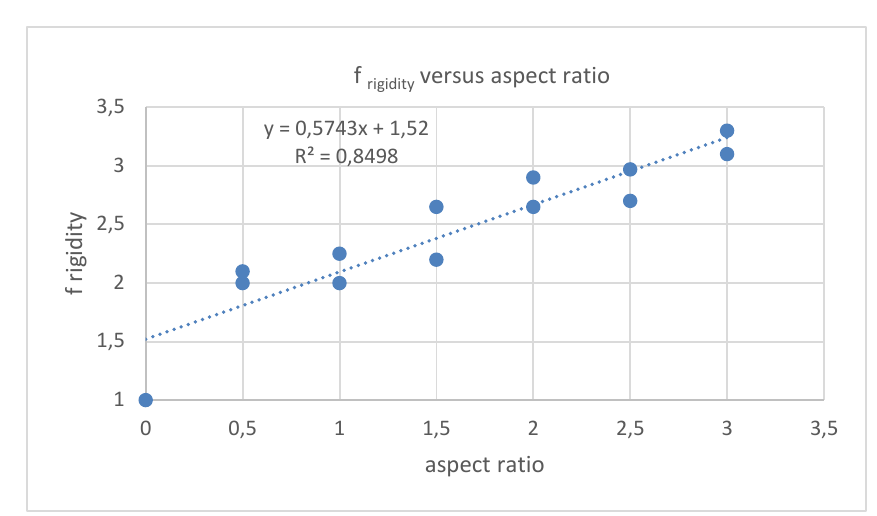
Fig. 4: rigidity factor as a function of aspect ratio using all the measured H